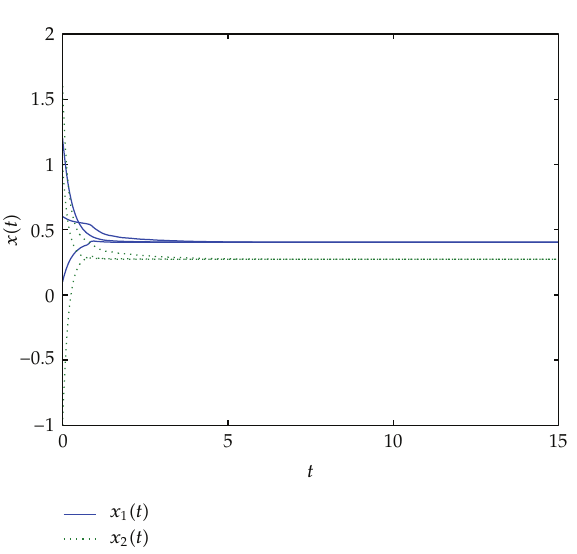
Figure 1: Time responses of the state variables x (cid:4) t (cid:7) with di ff erent initial values in Example